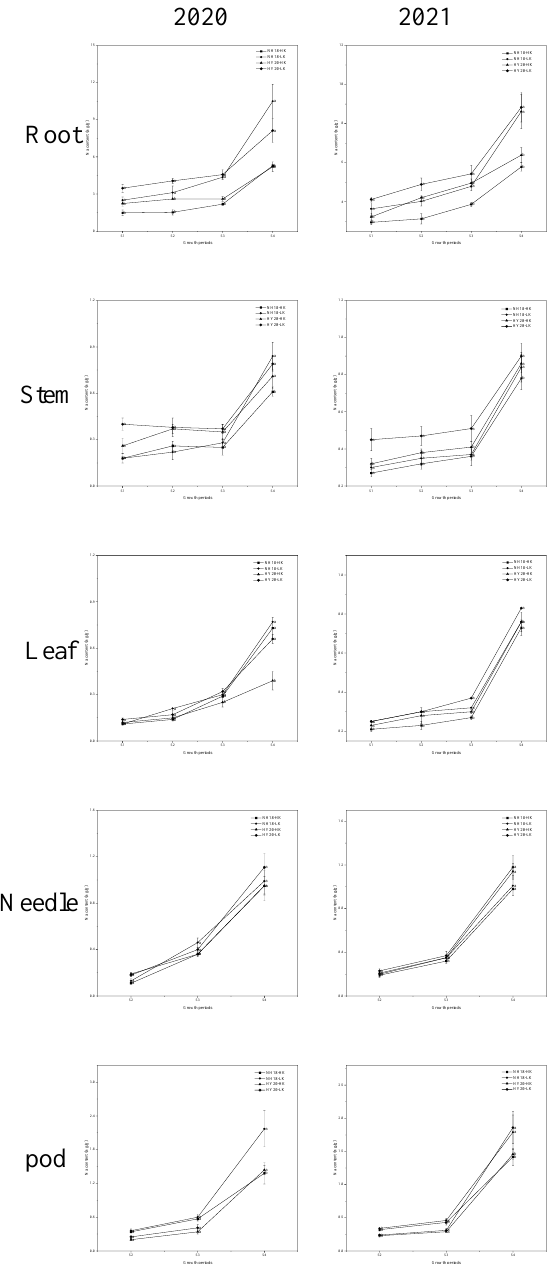
Figure 12. Changes in sodium (Na) content in peanut organs under low K stress (mg/g). HK: high K treatment; LK: low K treatment. For the figure, a,b indicates a significant difference between different treatments for the same variety ( p < 0.05).